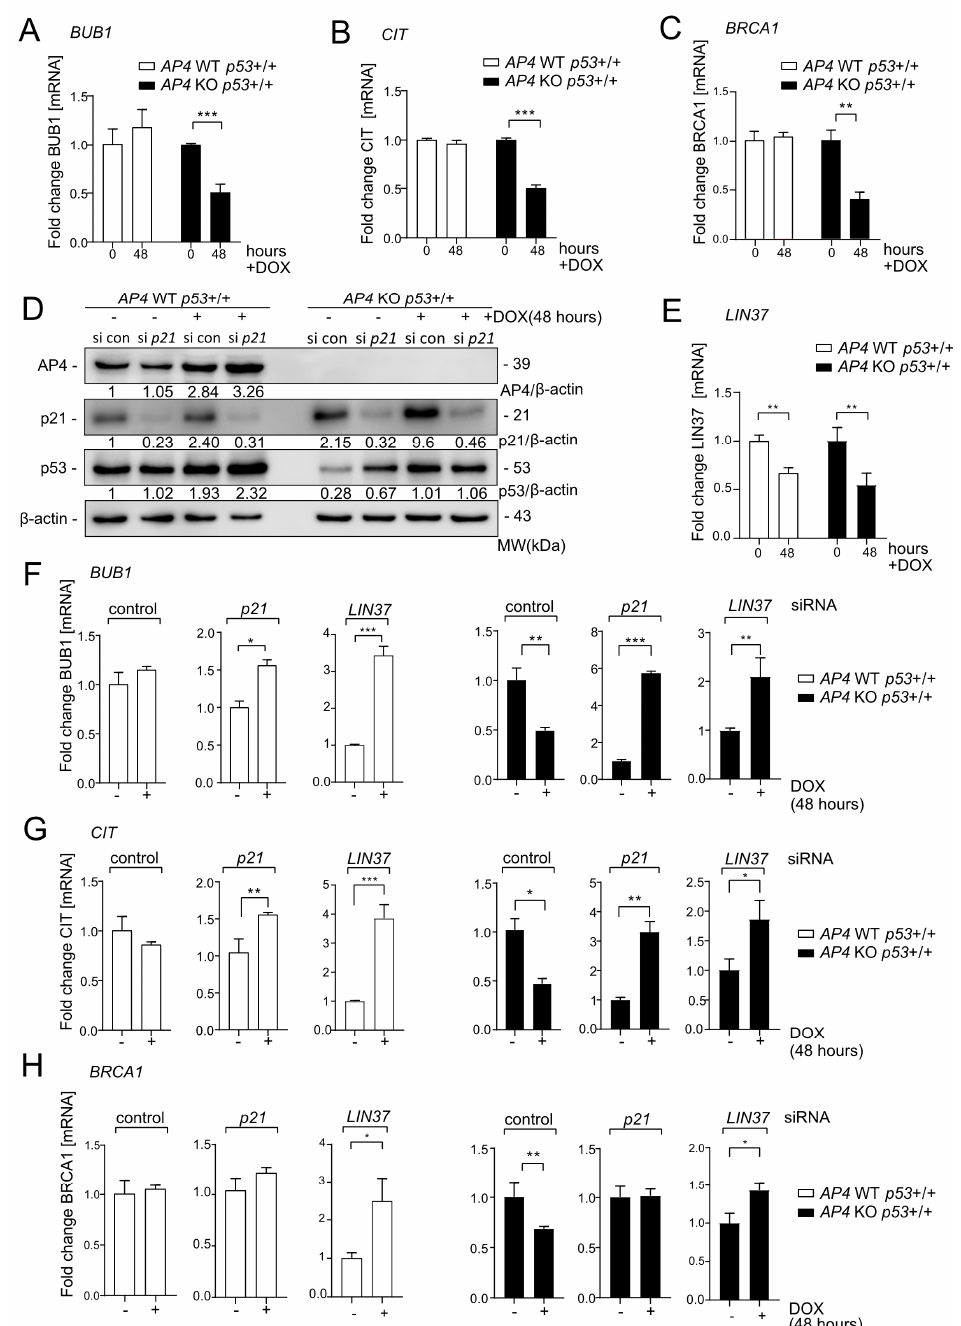
Figure 9. c-MYC-induced down-regulation of DREAM target genes in AP4 -deficient breast cancer cells is dependent on p21 and LIN37. ( A – H ) Cells were pre-treated with ICI for 72 h before addition of DOX for 48 h. ( A – C ) qPCR analysis of BUB1 , CIT , and BRCA1 expression after induction of c-MYC in MCF7-pRTR- c-MYC cells. ( D ) Western blot analysis of AP4, p21, and p53 expression after p21 siRNA (si p21 ) or control siRNA (si con) transfection and activation of c-MYC with DOX for 48 h. β -actin served as a loading control. € qPCR analysis of LIN37 expression after induction of c-MYC in p53 wild-type cells with the indicated AP4 genotype. ( F – H ) qPCR analysis of BUB1 , CIT, and BRCA1 expression after induction of c-MYC in p53 wild-type cells with the indicated AP4 status after transfection with p21 - or LIN37 -specific siRNAs, or control siRNA. Cells were transfected with siRNAs immediately before addition of DOX.( A – C , E , F ) Results are presented as mean +/ − SD (n = 3) with *: p < 0.05, **: p < 0.01, ***: p < 0.001. The uncropped blots are shown in Figure S1.